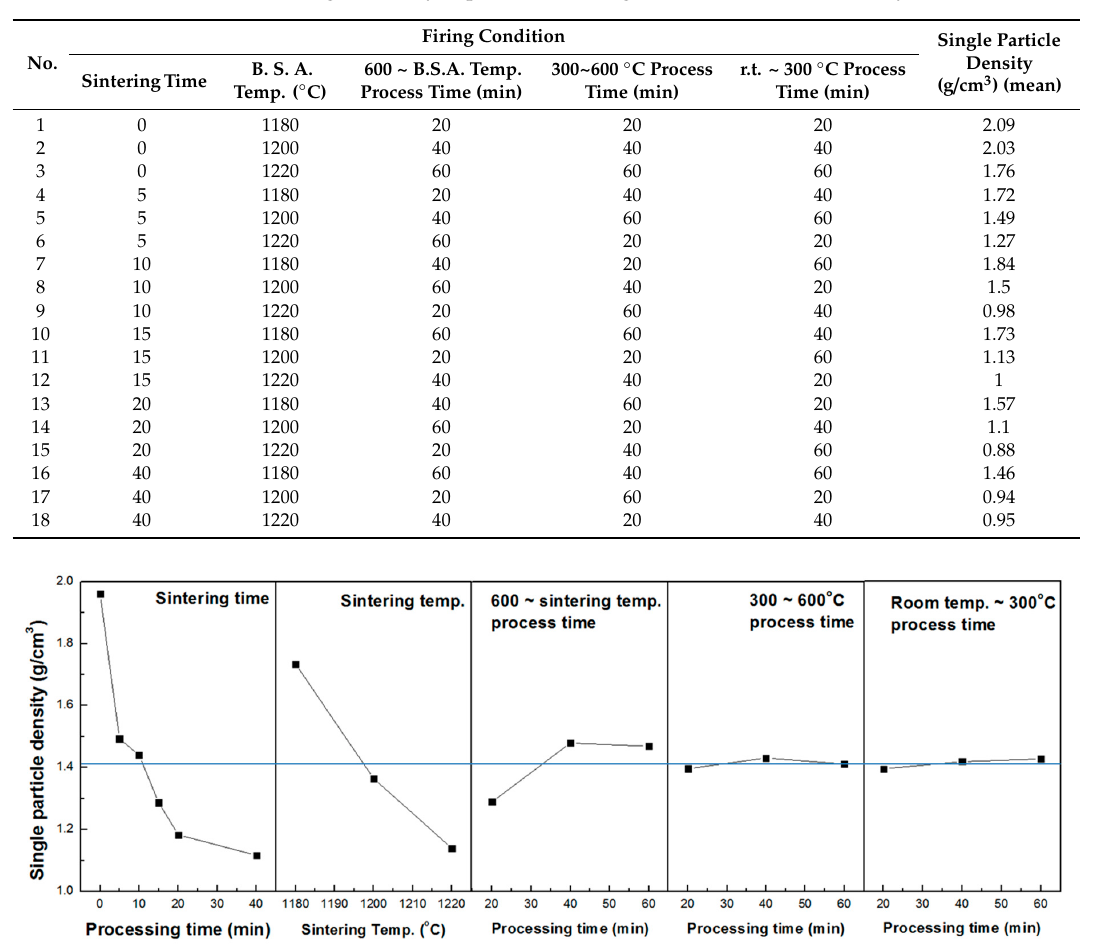
Table 2. Orthogonal array experimental design and the measured density.